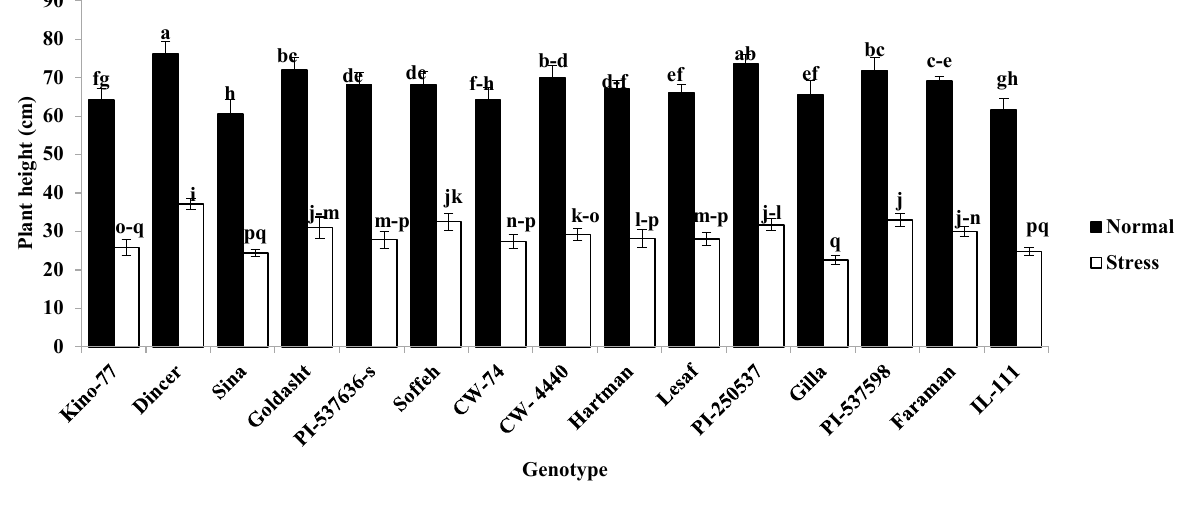
Fig. 1 Interaction effect of irrigation and genotype on plant height. Mean values with the same letters are not significantly dif- ferent ( p > 0.05) according to the Duncan test. Data are presented as mean ± SEM .